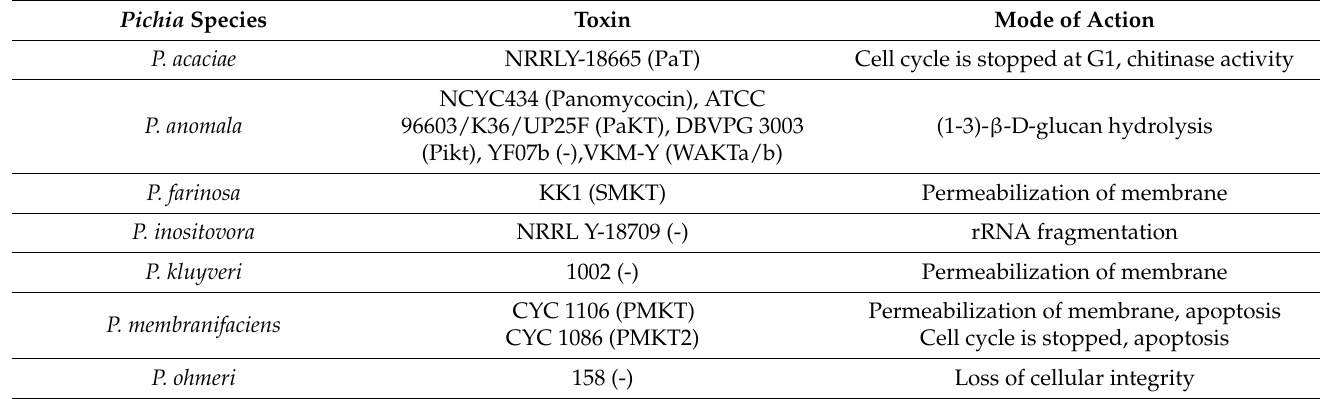
Table 2. Killer toxins and their mode of action of Pichia spp.